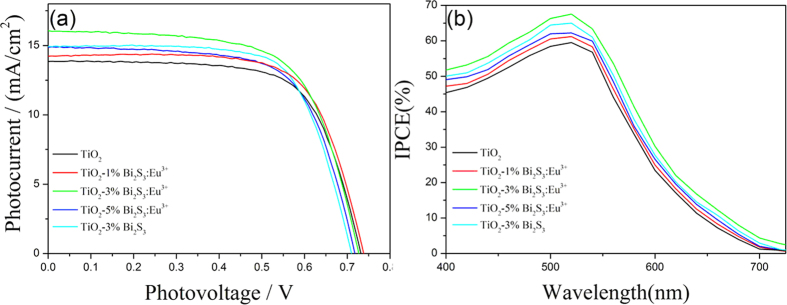
Photocurrent-voltage (I–V) curves (a) and IPCE (b) of TiO2, TiO2-Bi2S3, and TiO2-Bi2S3:Eu3+ cells with different concentration of Bi2S3:Eu3+.